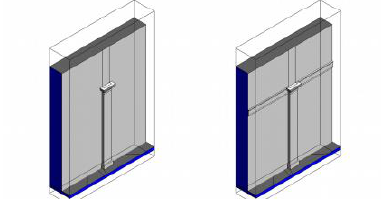
Figure 11. Modelling of pilaster and moulding in Revit space